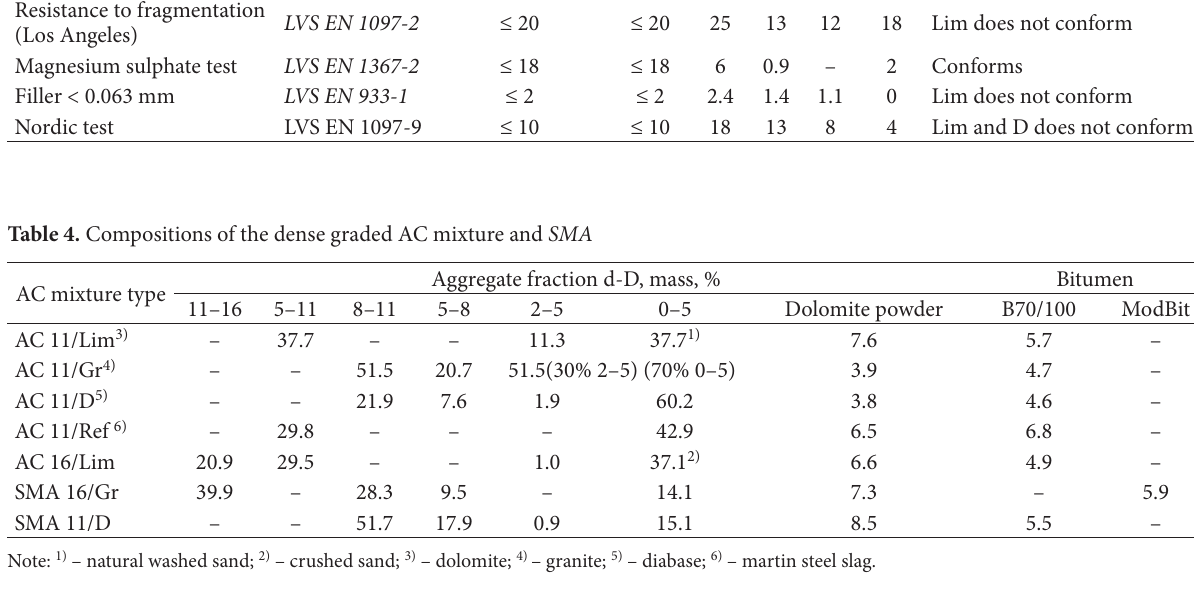
Table 5. AC deformation parameters µ and α Material parameter